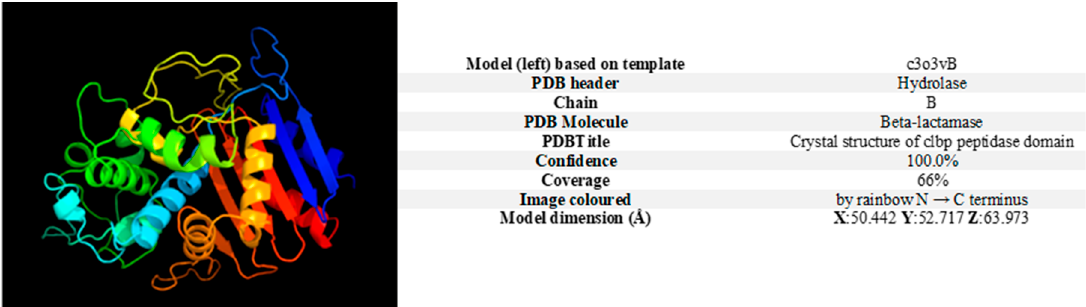
Figure 1. A 3D model of the ClbP enzyme was created using the Phyre2 web portal for protein modelling, prediction, and analysis (http://www.sbg.bio.ic.ac.uk/phyre2/html/page.cgi?id=index (accessed on 22 November 2021)).